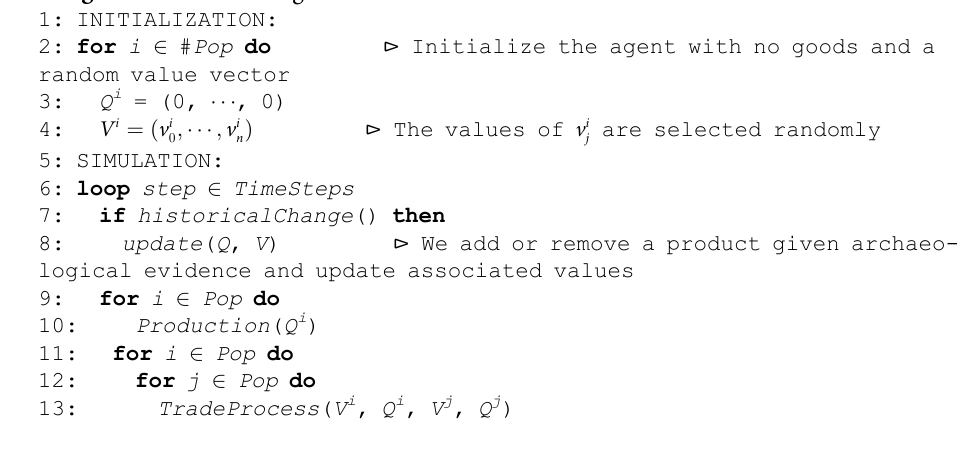
Algorithm 1 Model’s algorithmic